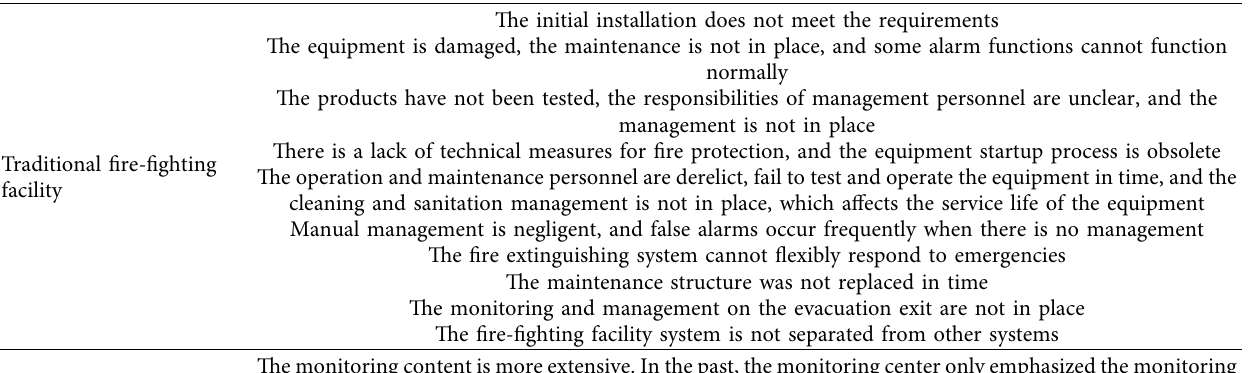
Table 13: Comparison of traditional and AI fre-fghting